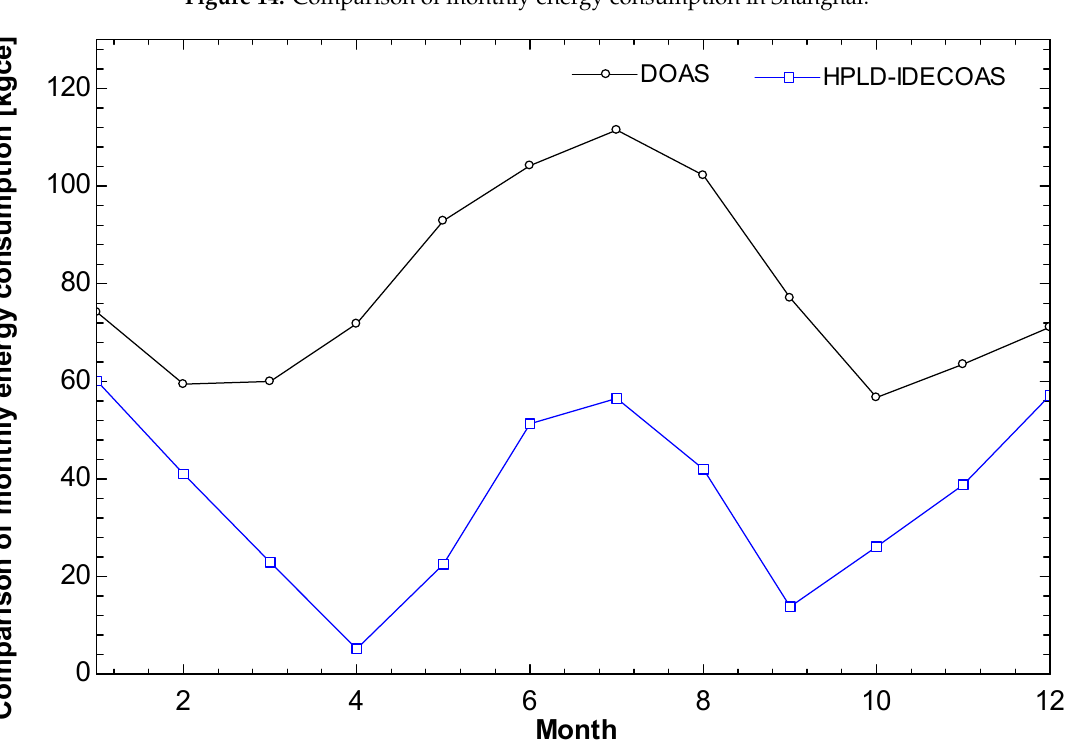
Energies 2019 , 12 , x FOR PEER REVIEW Figure 14. Comparison of monthly energy consumption in Shanghai. Figure 14. Comparison of monthly energy consumption in Shanghai.